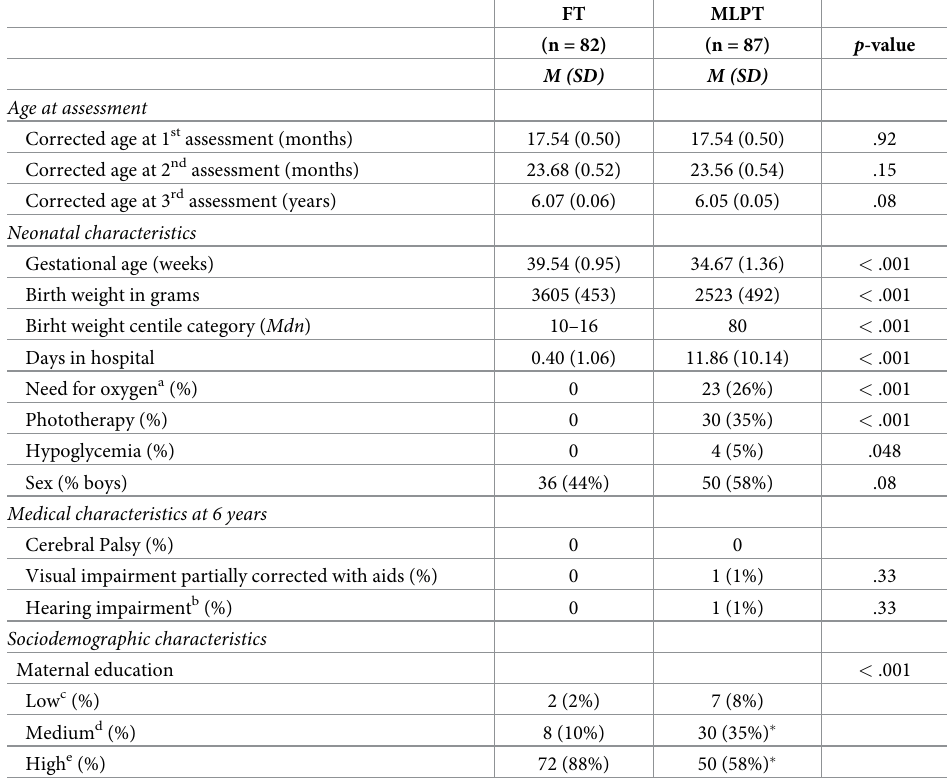
Table 4. Participant characteristics per birth status group (N =